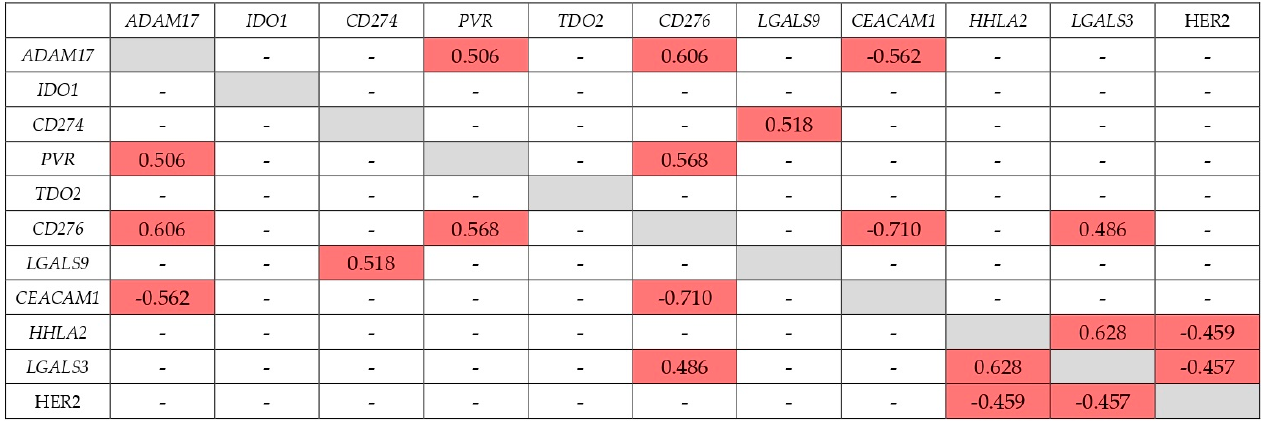
Figure 3. Correlation of expression at stage IV (metastatic GC). significant correlation; there is no significant correlation.